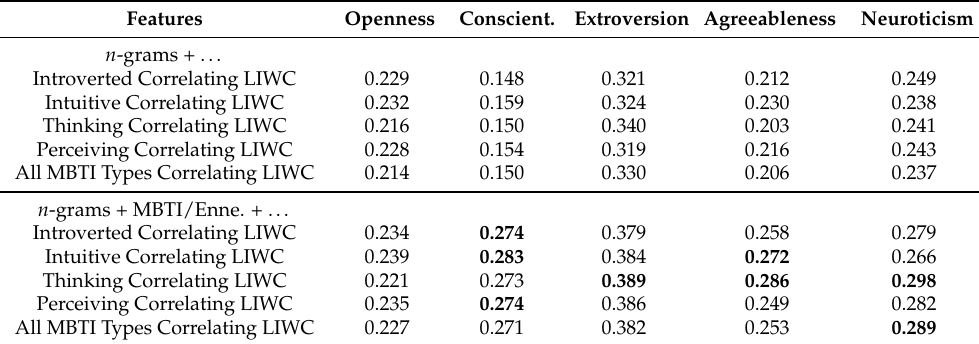
Table 12. The Pearson correlation coefficient between the actual Big Five traits and the ones predicted using combinations of n -grams, MBTI/Enne. predictions and various LIWC dimensions are divided in sets based on which MBTI type they correlate